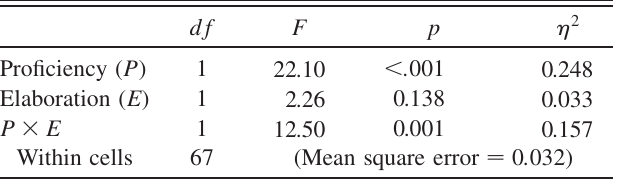
TABLE VIII. ANOVA with electricity problem-sorting score as dependent variable.